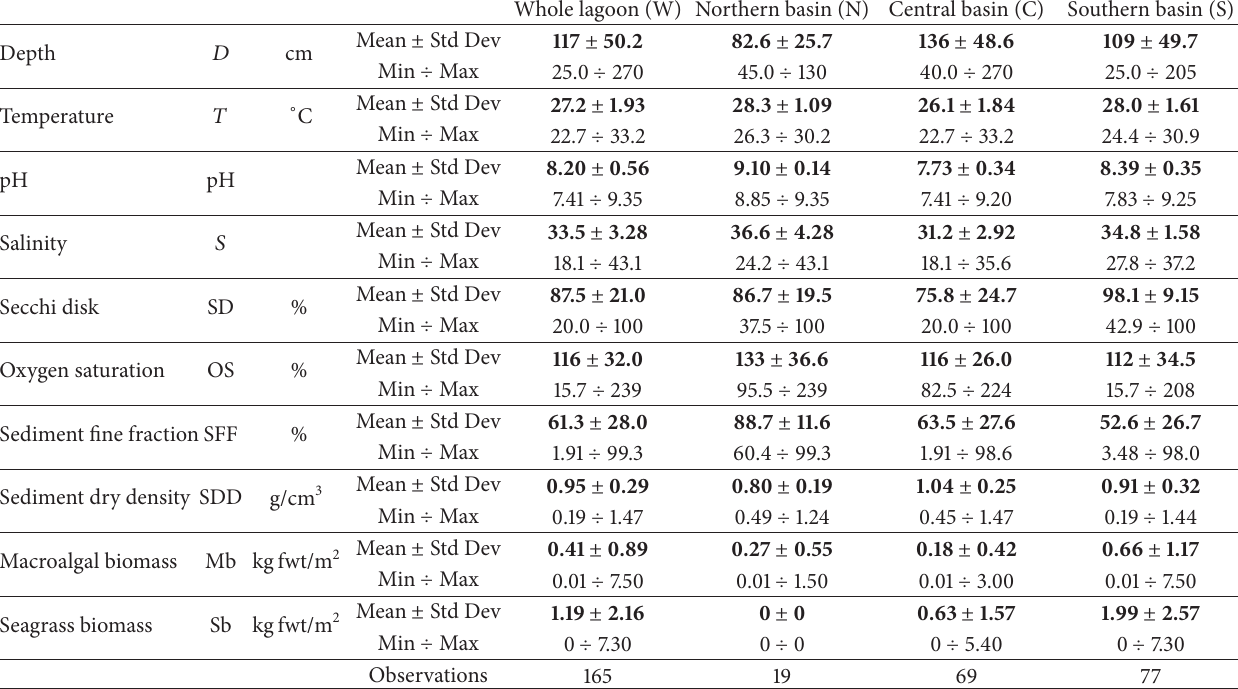
Table 1: Abiotic and biotic data measured in Venice Lagoon and sub-basins in 2003 survey (mean ± standard deviation (Std Dev), minimum (Min) and maximum (Max)